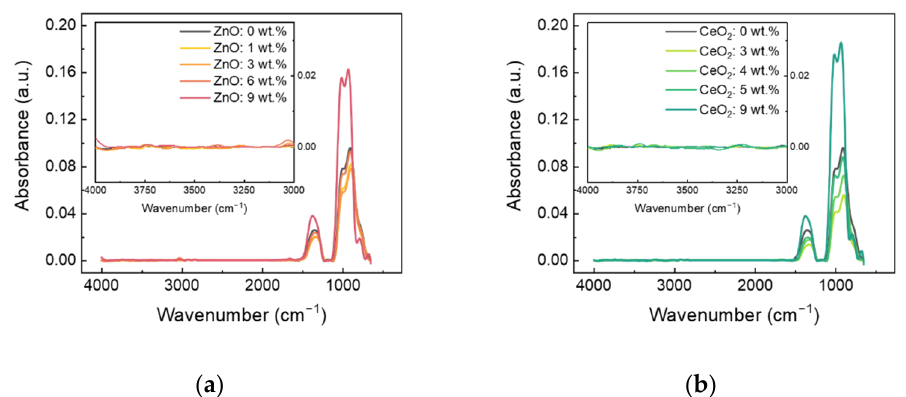
Figure 5. FTIR spectroscopy of ( a ) ZnO-doped ITO and ( b ) CeO 2 -doped ITO. The inset shows a detail of the OH stretching vibration area. Although Zn and Ce have different bond enthalpies with oxygen, there is no change in the OH stretching vibration region according to the doping amount.